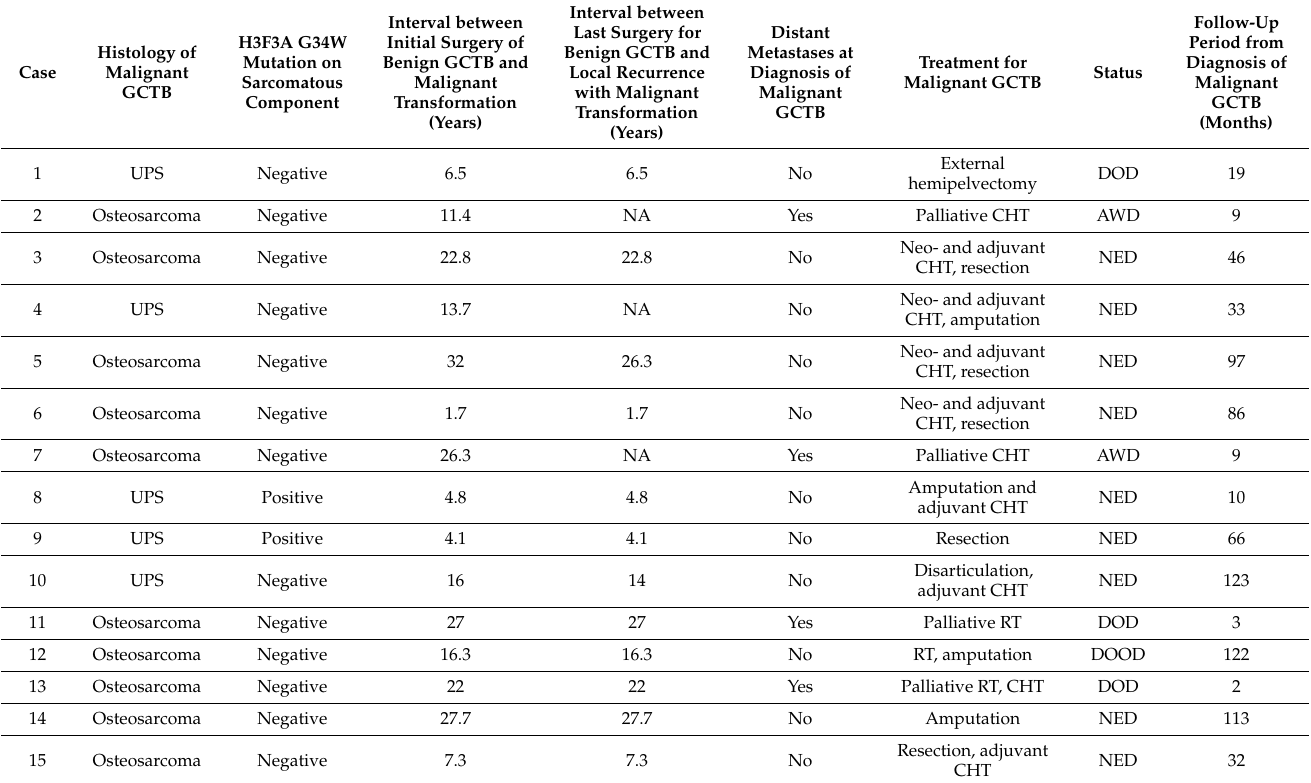
Table 3. Details of 15 patients who experienced malignant transformation from benign GCTB.